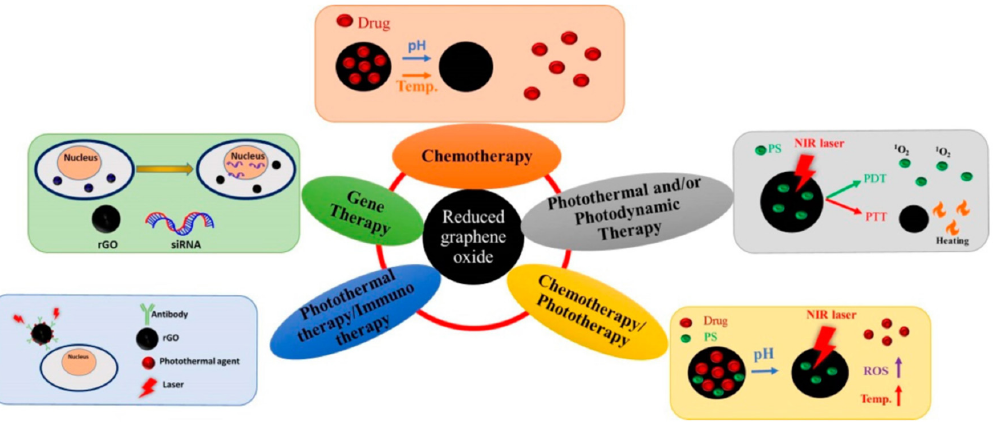
Figure 7. Applications of r-GO in PDT and PTT, chemotherapy/phototherapy, photothermal/immune therapy, gene ther- apy, and chemotherapy. Reproduced from Ref. [76] with permission from